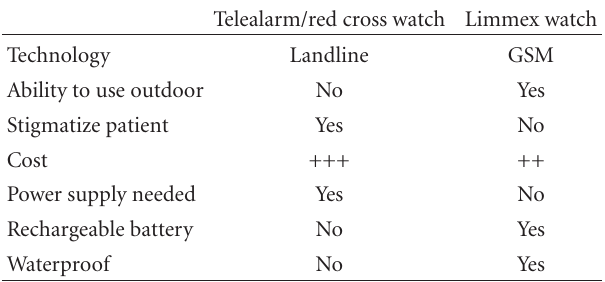
Table 1: Comparison between telealarm/red cross watch and Limmex